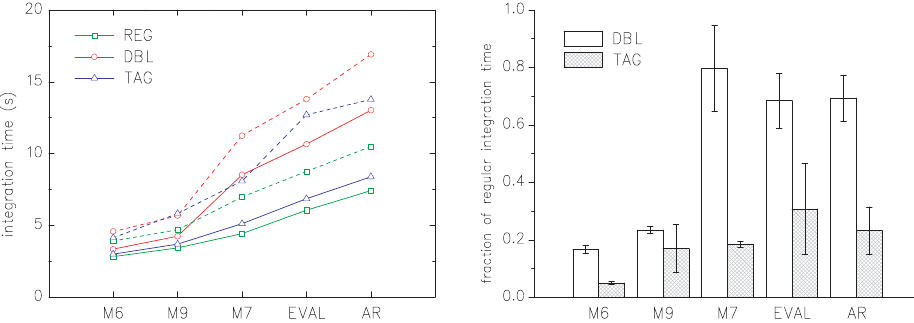
Fig. 7. Left: total time spent to integrate the regular, doubled and tagged systems. Solid and dashed lines denote “free” and “forced” regimes, respectively (see text for details). Right: the average additional time required for the doubled and tagged systems as a fraction of the regular mechanism integration time. The vertical lines on the top of the bars represent the variability due to the different